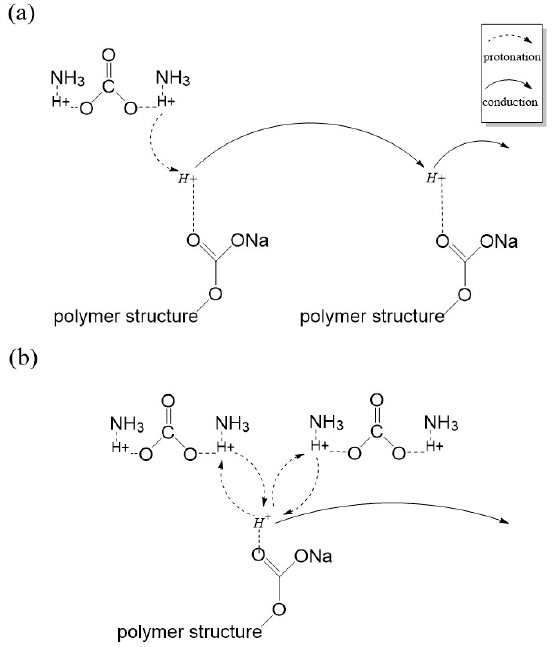
Table 4. The respective area and percentage of free ions and contact ions of each sample. Sample